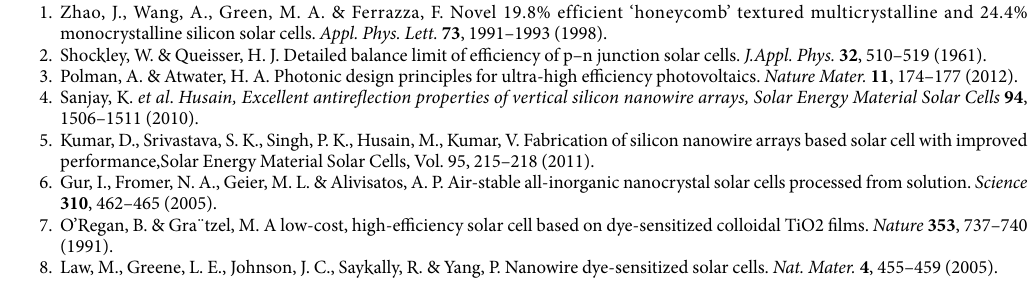
quantum tunneling effect are obviously observed. The negative resistance phenomenon and the resonant vibra- tion between the twin states in light field are measured, which have the characteristic of the quantum vibration confined in the localized states. The amplitude change of the quantum vibration with ∆ E~10 meV is observed on the pillars sample II prepared in oxygen in magnetic field with 0.33 T, which is related to the electron spin in the localized states.